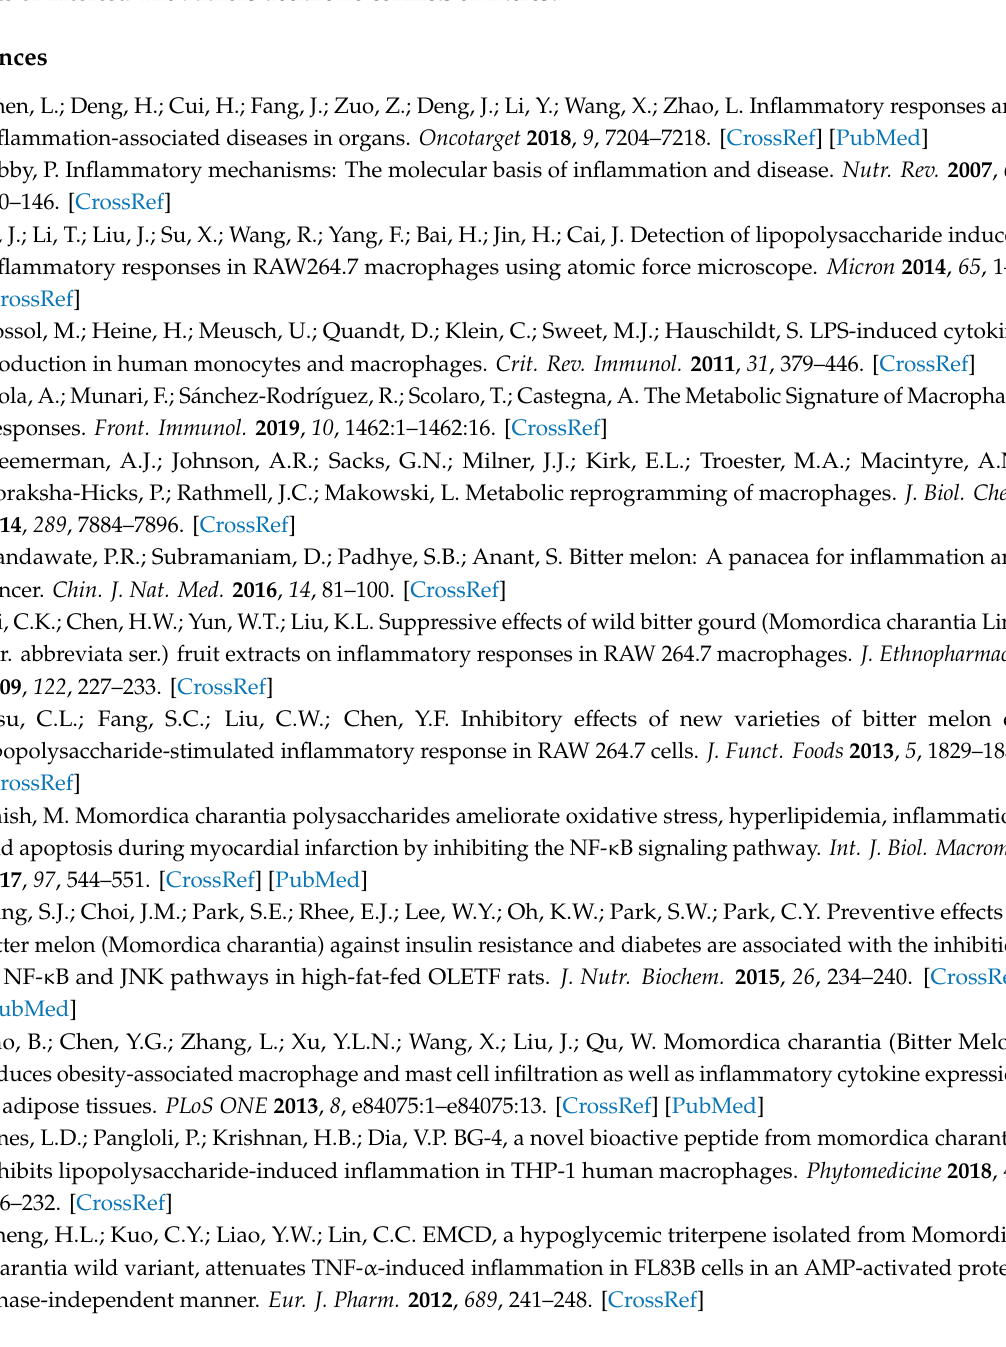
figures and a table: Figure S1: E ff ect of LPS and MC treatment on the expression of selected inflammatory genes, Figure S2: E ff ect of LPS and MC treatment on the expression of selected genes in glucose metabolism, Figure S3: Cell viability assay of RAW264.7 cells treated with Momordica charantia extract, Figure S4: Cell viability assay of RAW264.7 cells treated with charantin, Supplementary Table S1: List of primer sequences used in